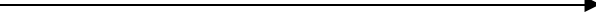
Fig. 9a–c. Distribution of vertical parameters for the altitudes ranged from 30–40 km, 40–50 km and 50–60 km resulting from 15 nights of observation from late May to late November in 1994: a vertical wavelengths b mean vertical phase speeds, and c observed periods